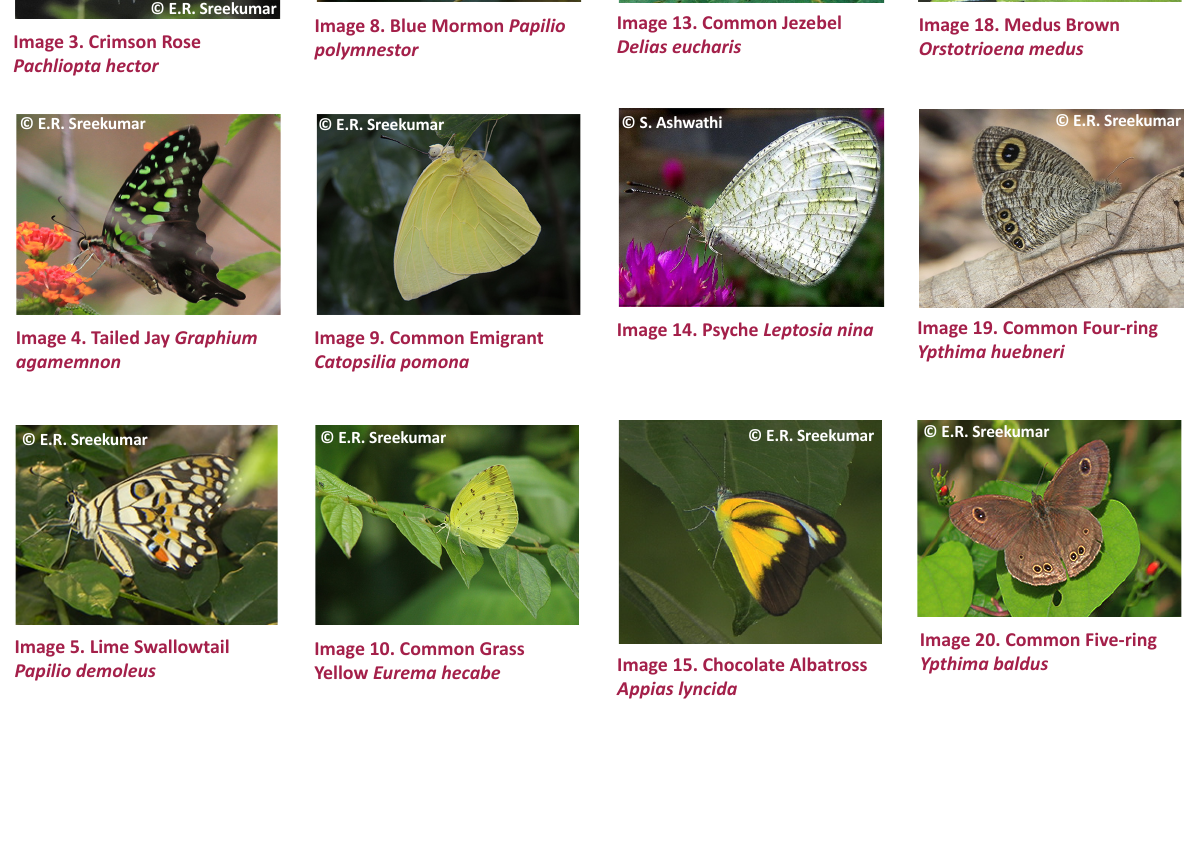
Image 18. Medus Brown Orstotrioena medus